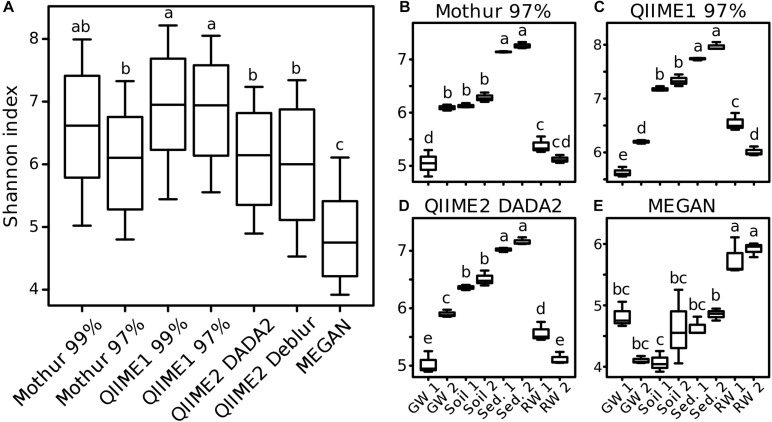
Comparison of alpha-diversity indices for environmental samples. For each analysis pipeline, Shannon indices were calculated either on all samples combined (A) or each sampling site separately (B–E): GW, groundwater; Sed., sediment; RW, river water; 1 and 2 indicate sampling sites. Significance of differences between samples (One-way ANOVA followed by Tukey multiple comparisons of means, p < 0.05) is marked by lowercase letters so that samples that share at least one letter are not significant different (e.g., “a” and “ab”) but samples that do not share a letter are significant different (e.g., “a” and “b”).